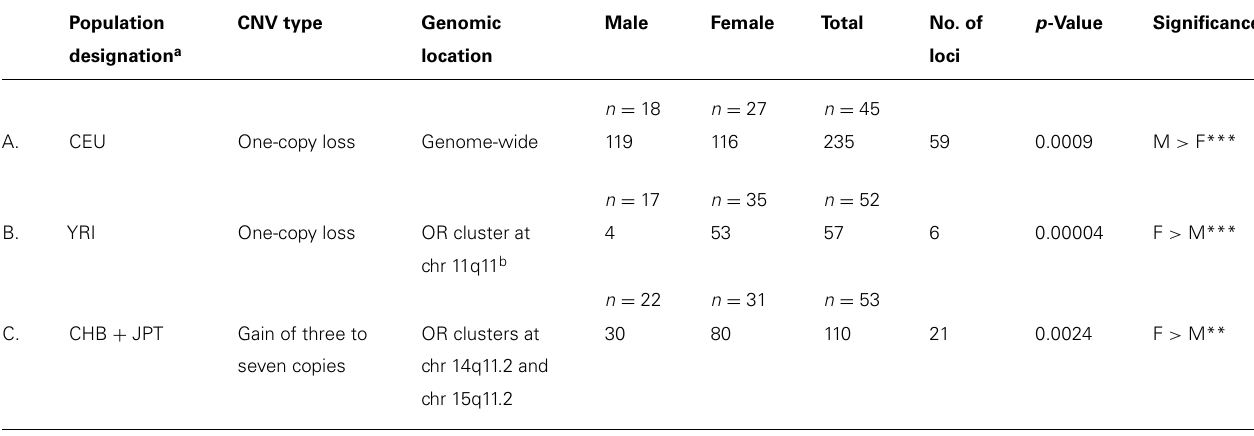
Table 6 |Within-population sex bias in CNV numbers in each of the three diverse populations.